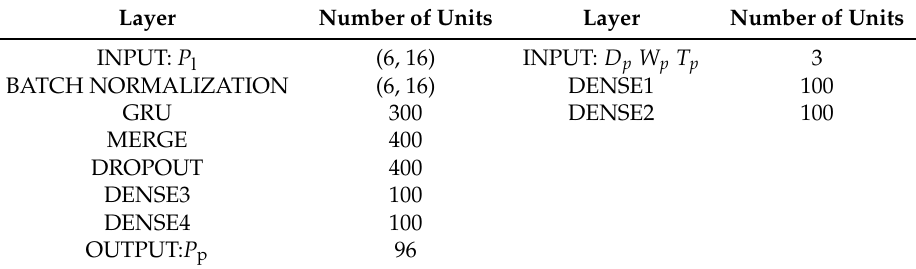
Table 5. Number of units in the proposed network.